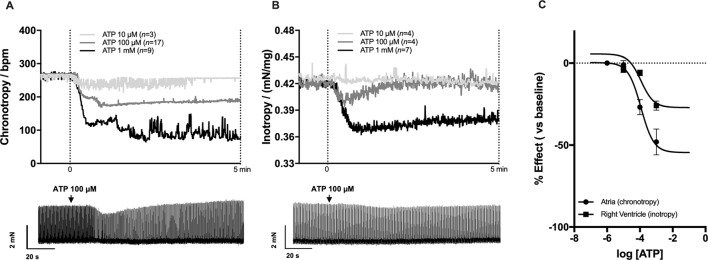
Effects of ATP on spontaneously beating atria (A, chronotropy, beats min−1) and 2 Hz-paced right ventricular (B, inotropy, mN/mg of tissue) strips from Wistar rats. ATP (0.01–1 mM) was applied non-cumulatively for 5 min followed by a washout period to avoid biases resulting from bath accumulation of metabolites and from receptors desensitization. Upper panels (A) and (B) show average values; bottom panels show typical myographical recordings of atrial and ventricular preparations challenged with ATP (100 µM). Panel (C) shows the concentration-response curves for ATP (0.001–1 mM) fitted by four-parameter logistic sigmoidal functions used to estimate pEC50 values for the negative chronotropic and inotropic effects of the nucleotide. Data are expressed as mean ± SEM from an n number of animals indicated in upper panels (A) and (B), respectively.